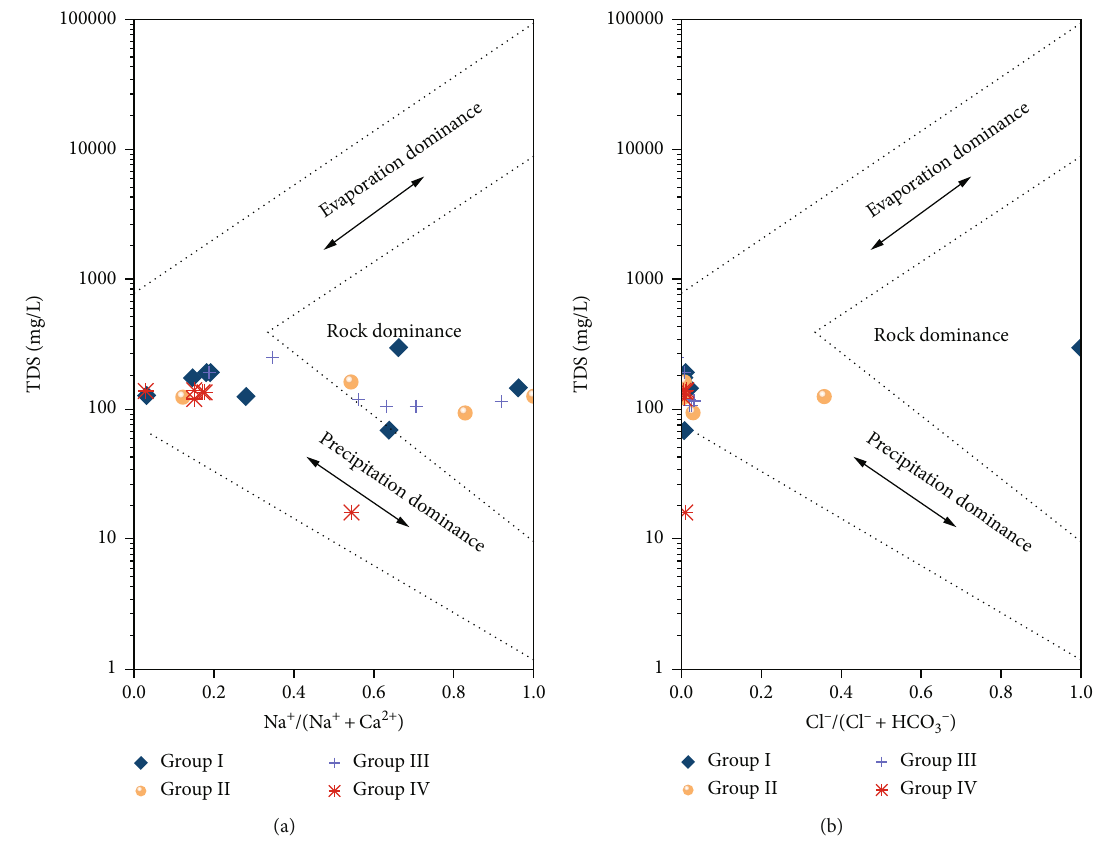
Figure 7: Gibbs plot of groundwater samples in the study area.